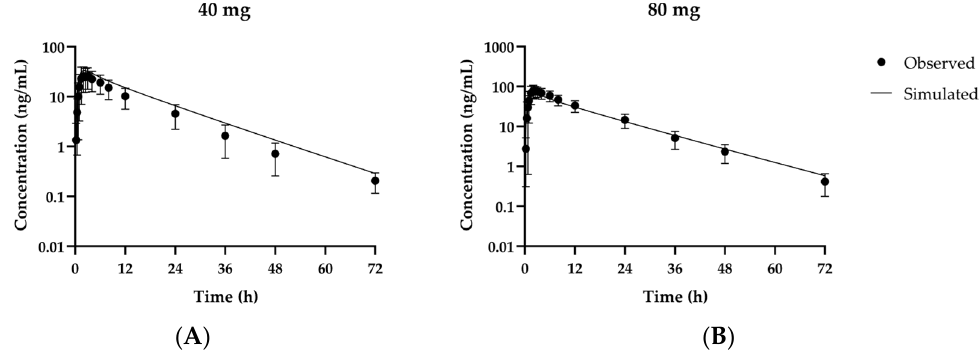
Figure 3. Observed and predicted fexuprazan concentrations at repeated doses of 20 mg/day ( A ), 40 mg/day ( B ), and 80 mg/day ( C ) administered to humans for 7 days. Solid lines represent simulated results of optimized model or model prediction. Closed circles ( ● ) represent observed data [10,22] . Data are means ± SD for eight healthy volunteers.